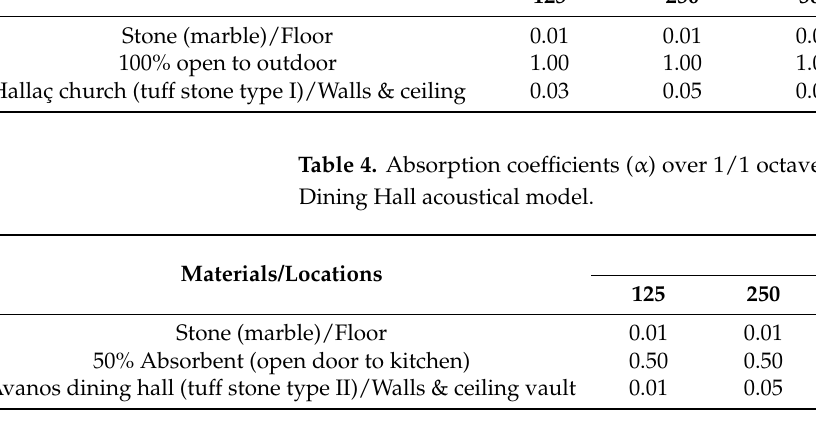
Table 4. Absorption coefficients ( α ) over 1/1 octave bands of the materials applied to the Avanos Dining Hall acoustical model.